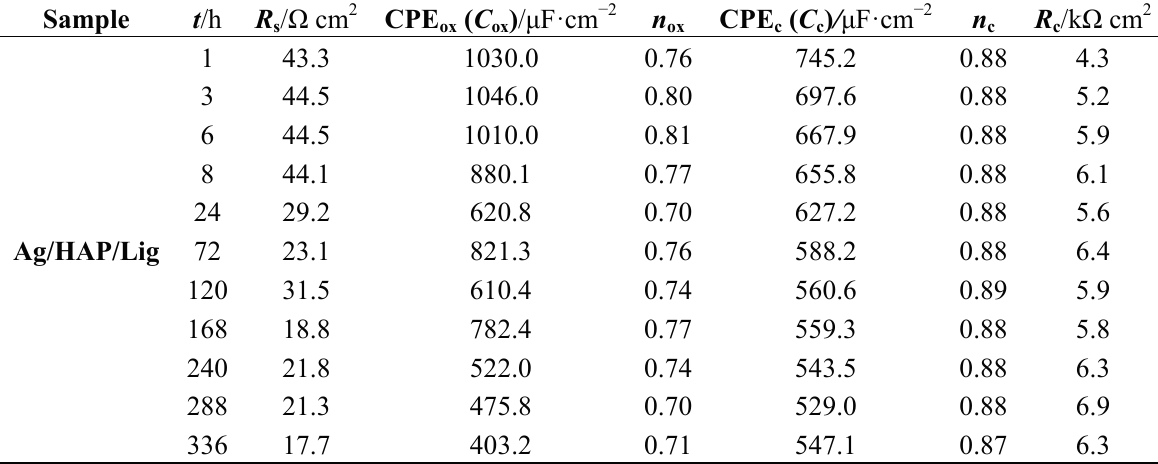
Table 3. The fitting values of equivalent electrical circuits for sintered Ag/HAP/Lig coating. Reprinted from [39] with permission. Copyright American Chemical Society